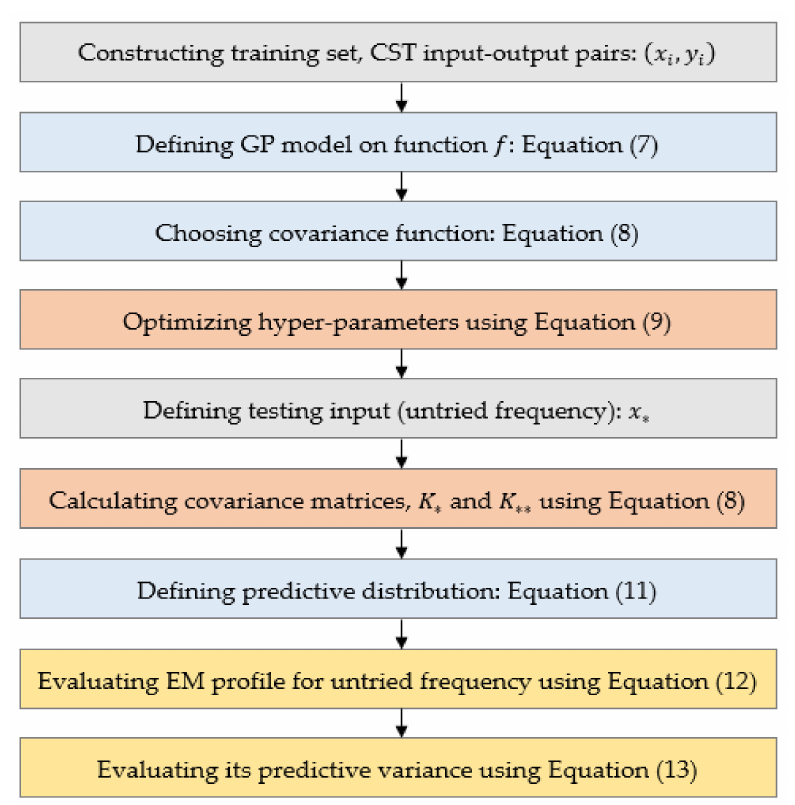
Figure 2. Simplified methodological flow of GP regression modelling in SBL data generated through the CST